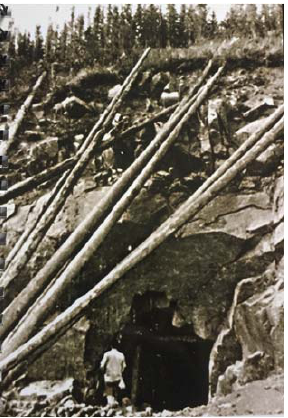
Figure 11 : Entrance to one of the galleries of the Natzweiler camp in 1945 (CERD).